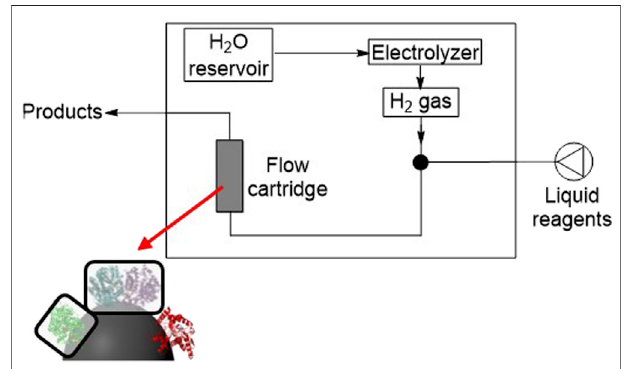
FIGURE4 | Schematic representation ofthe fl owreactor, showing built- in electrolyzer for in situ H 2 gas generation, with a fl ow cartridge containing carbon-supported biocatalysts.